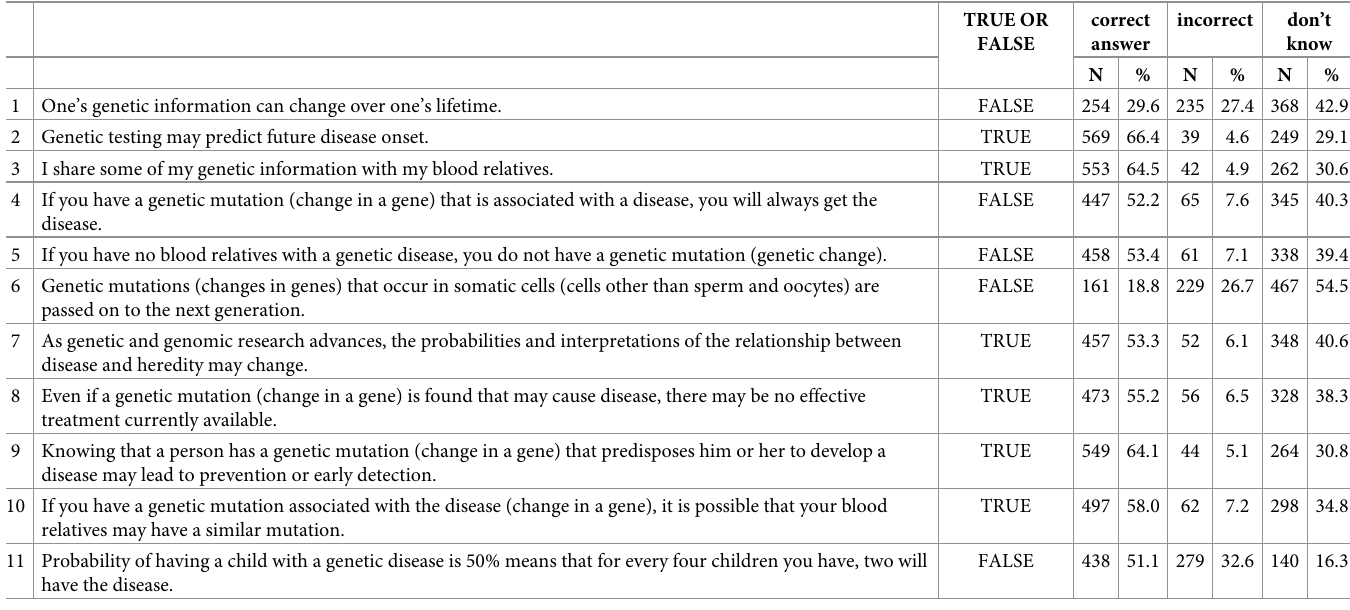
Table 2. The correct answer rates for genetic/genomic knowledge.